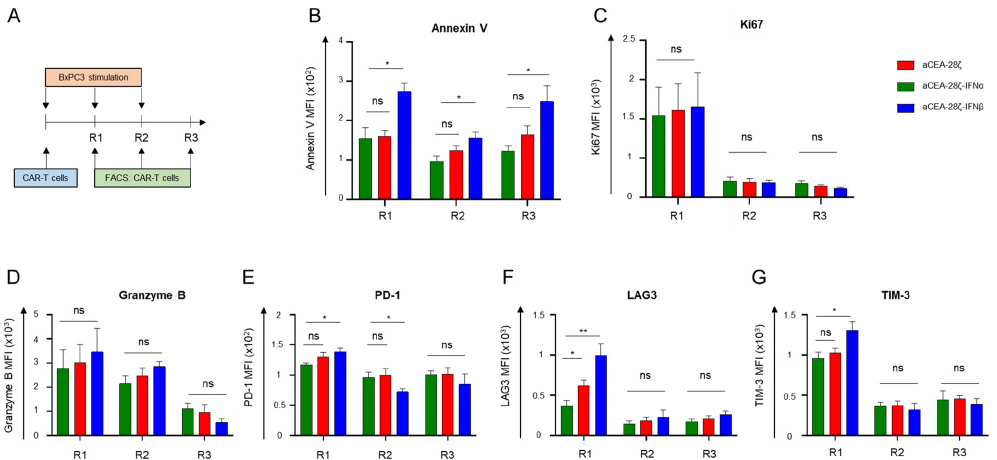
Figure 4. Enhanced apoptosis in IFN β -CAR T-cells. ( A ) Experimental design of the repetitive antigen-stimulation assay. CAR T-cells were subjected to three rounds (R1–R3) of stimulation with CEA+ BxPC-3 cells. At the end of each round, CAR T-cells were stained for Annexin V ( B ), Ki67 ( C ), Granzyme B ( D ), PD-1 ( E ), LAG3 ( F ), and TIM-3 ( G ). Data represent geometric means of ± SEM of four donors, p values were calculated by Student´s t test, ns indicates not significant * indicates p ≤ 0.05, ** indicates p ≤ 0.01.